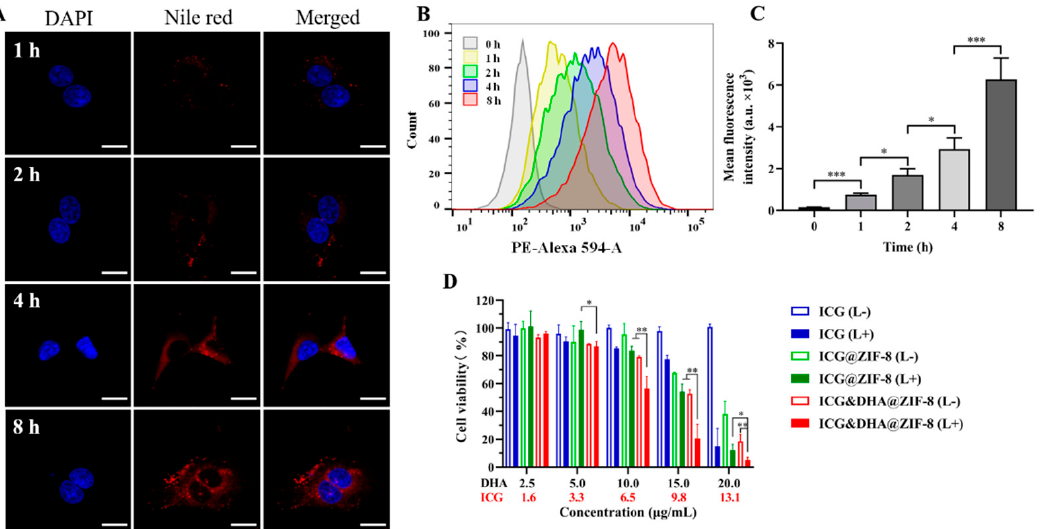
Figure 3. ( A ) Representative confocal microscopic images of cellular uptake after co-incubation with Nile Red&DHA@ZIF-8 for a specific amount of time (1 h, 2 h, 4 h, and 8 h). Scale bars, 20 μ m. ( B – C ) Flow cytometry and its quantitative results of cellular uptake after co-incubation with Nile Red&DHA@ZIF-8 for a specific amount of time (1 h, 2 h, 4 h, and 8 h) ( n = 3). ( D ) Relative cell via- bility of HepG2 cells after incubation with free ICG, ICG@ZIF-8, and ICG&DHA@ZIF-8 in the presence/absence of 808 nm light irradiation (“(L − )” means without laser irradiation, “(L+)” means with laser irradiation). * p < 0.05, ** p < 0.01, *** p < 0.001.